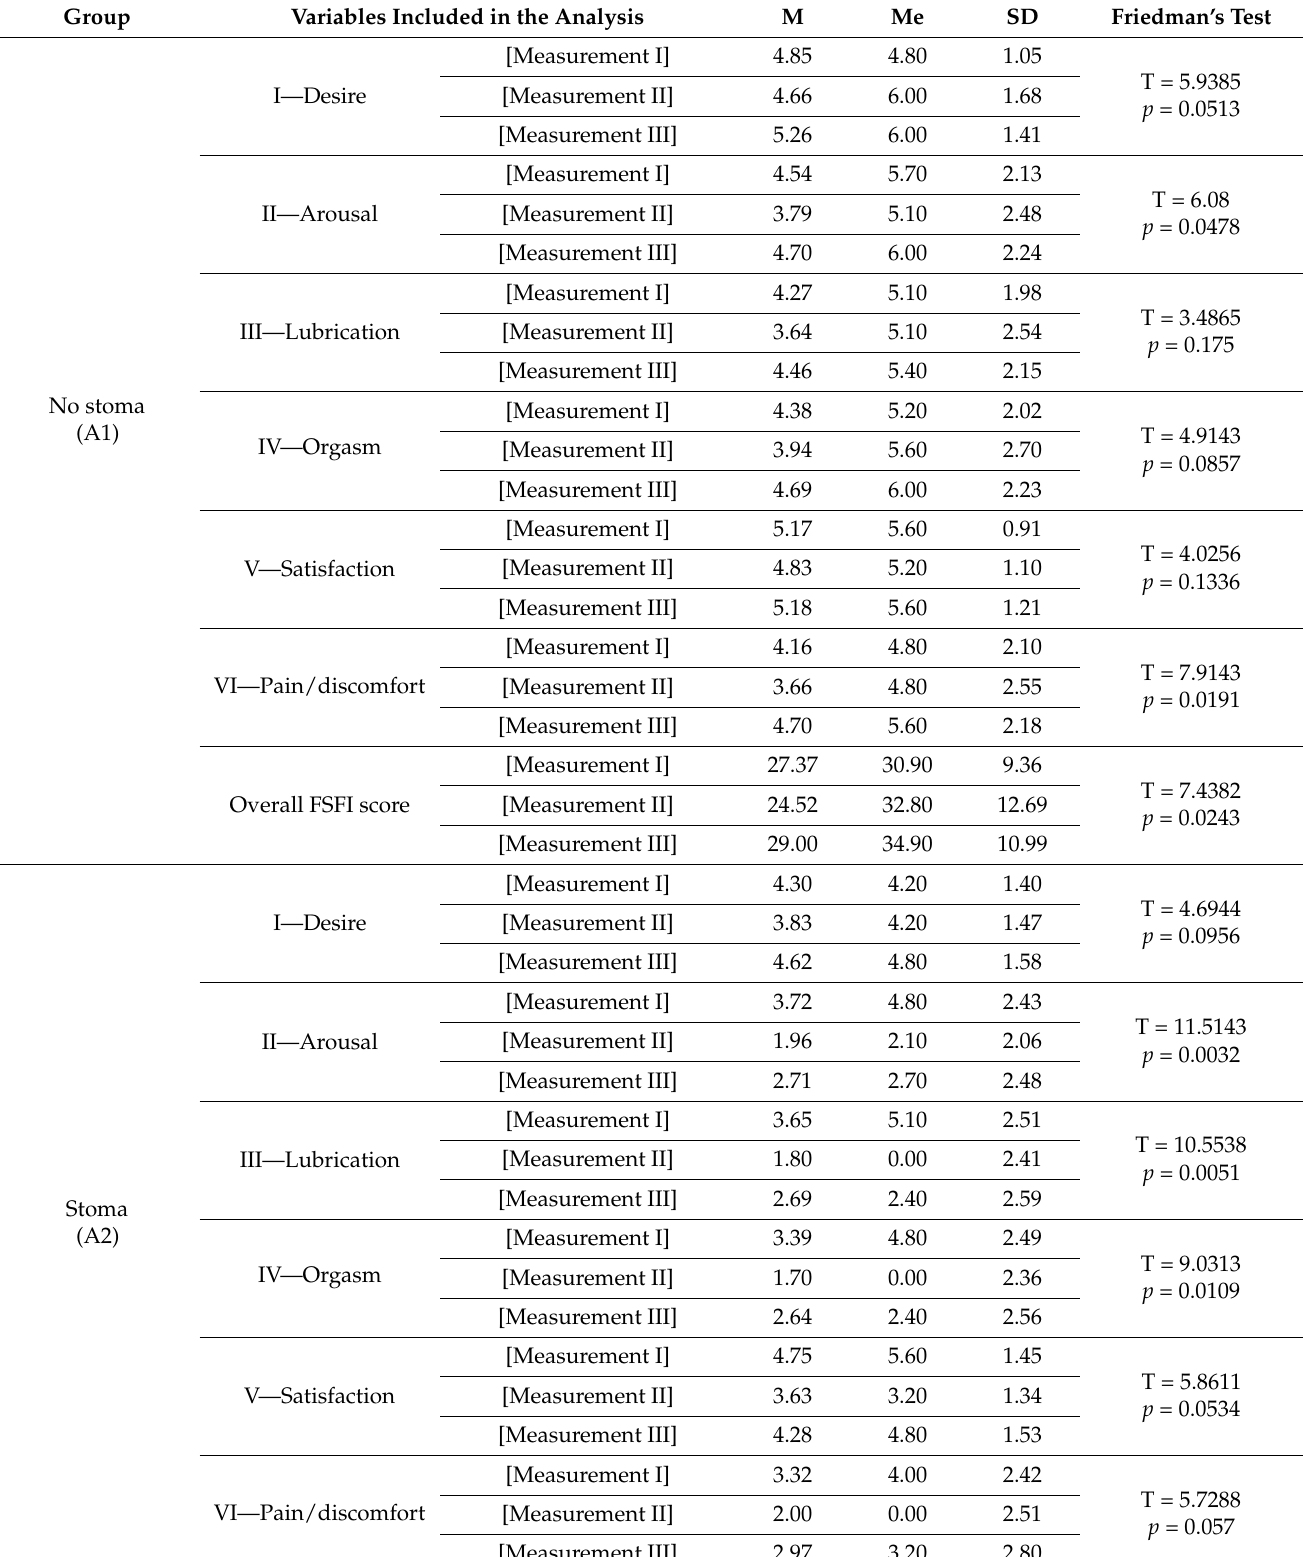
Table 4. FSFI scores at individual time